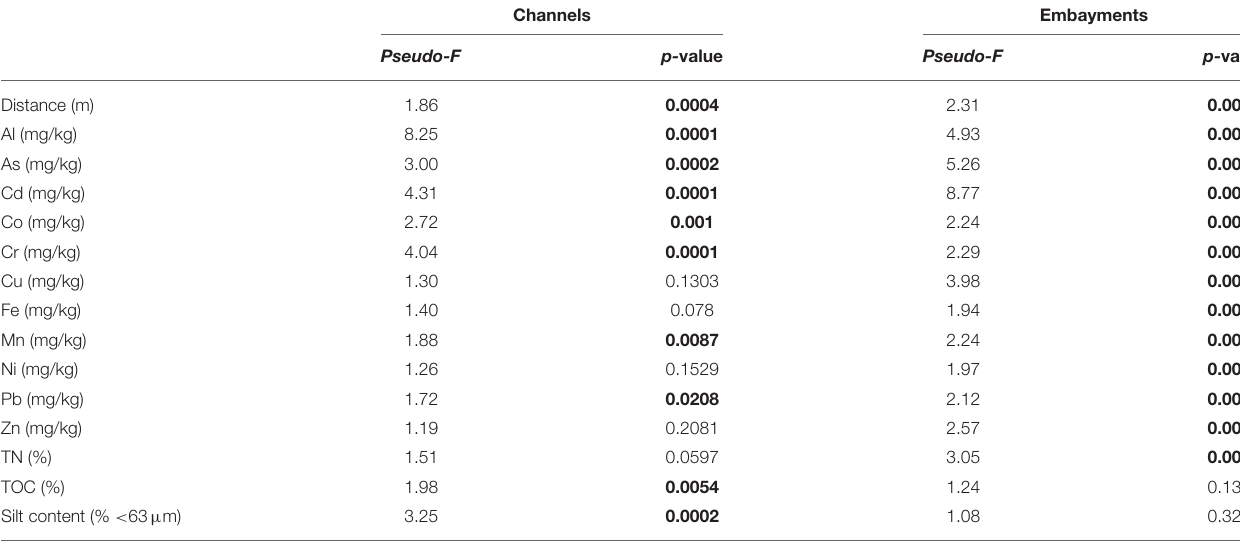
TABLE 3 | Statistical results of the PERMANOVA investigating potential drivers of benthic bacterial community composition. Channels Embayments Pseudo-F p- value